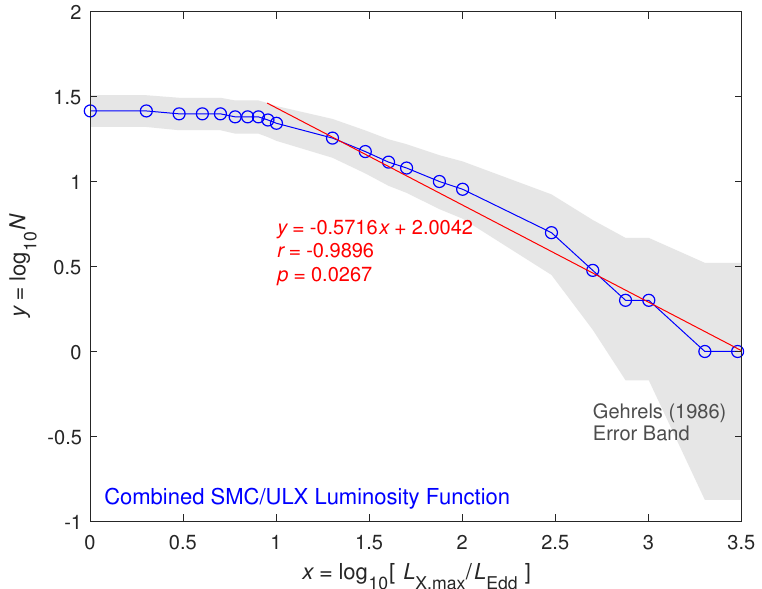
Figure 12. Cumulative number N of sources in the combined (1 + 4 = 5) data set above a luminosity level L X,max versus L X,max / L Edd on logarithmic scales (blue points). The grey area respresents the 1 σ error bars to the data points according to the prescription of [44]. The errors in the best-fit line are listed in row 5 of Table